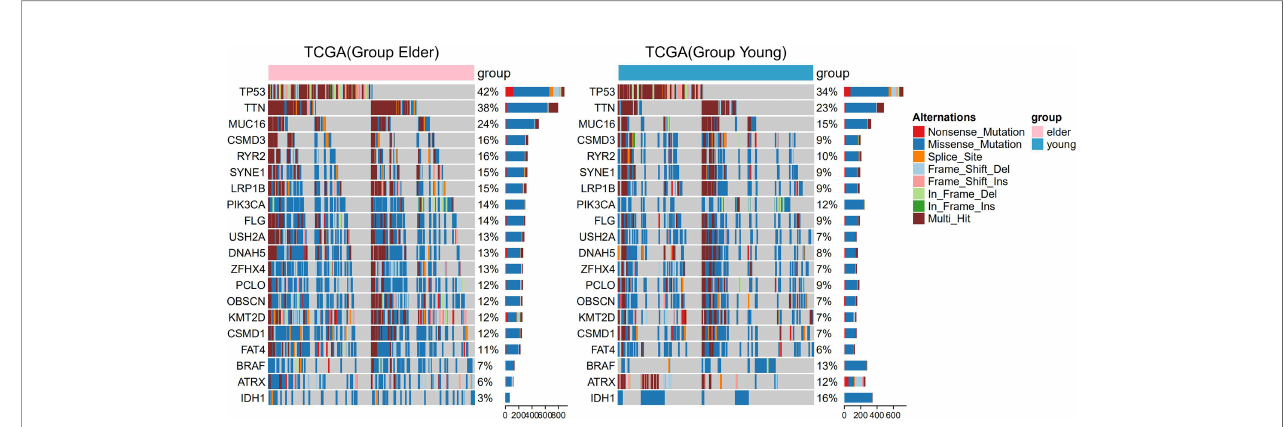
FIGURE 3 | Panoramic images of gene mutations in the elderly group ( ≥ 50 years old) and the young group of patients in The Cancer Genome Atlas (TCGA) pan- cancer dataset. The bar graph on the right shows the mutation frequency of each